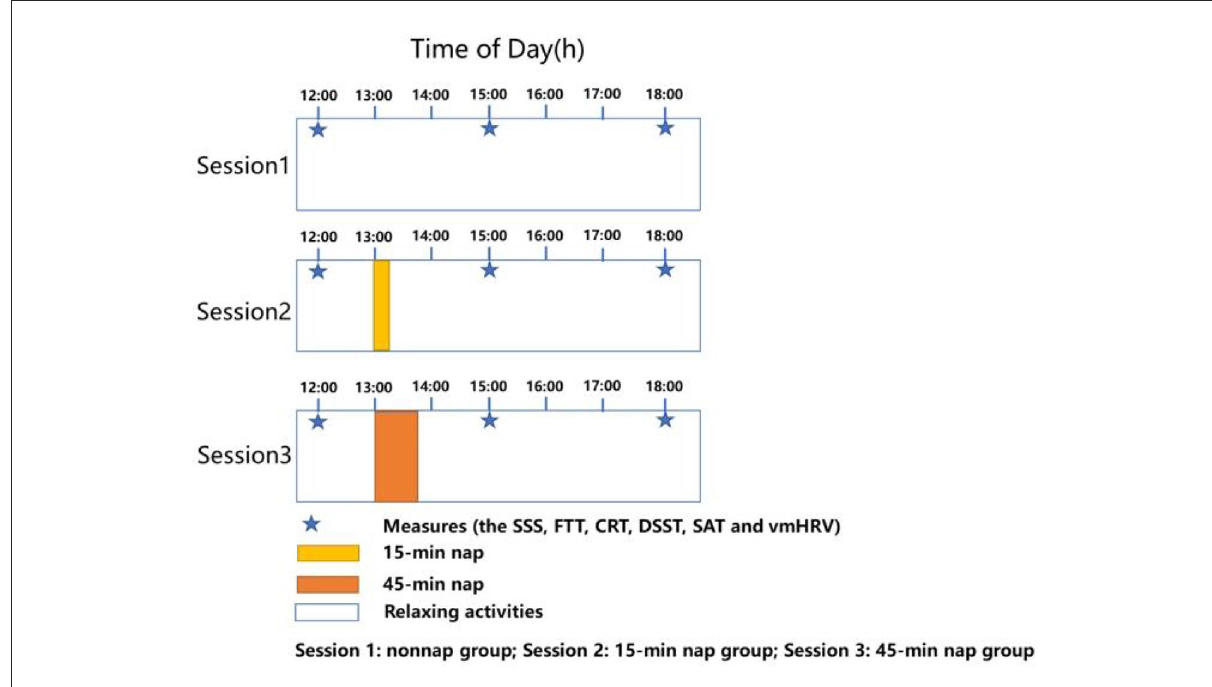
FIGURE1 Protocol